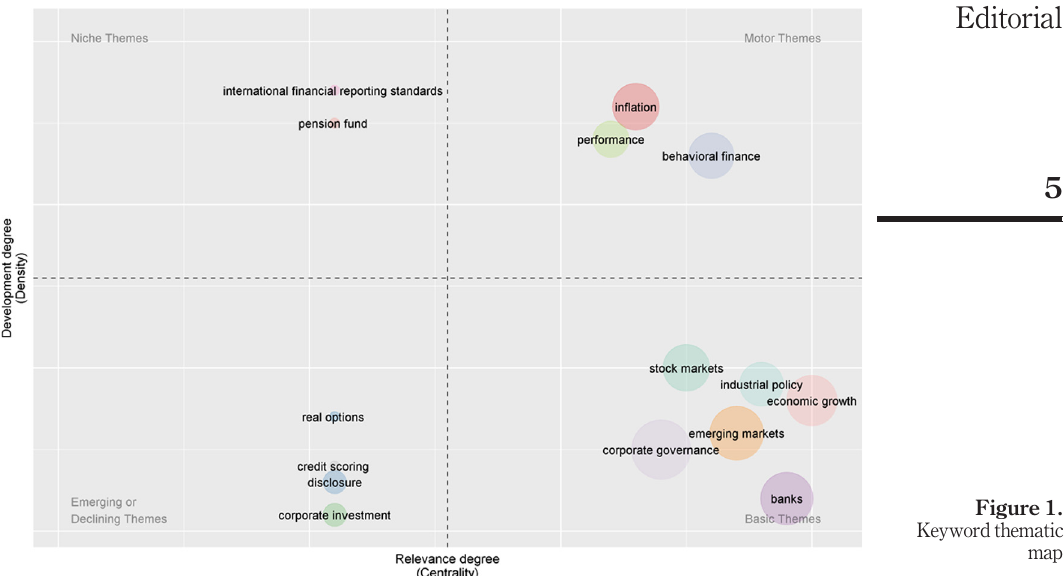
Figure 1. Keyword